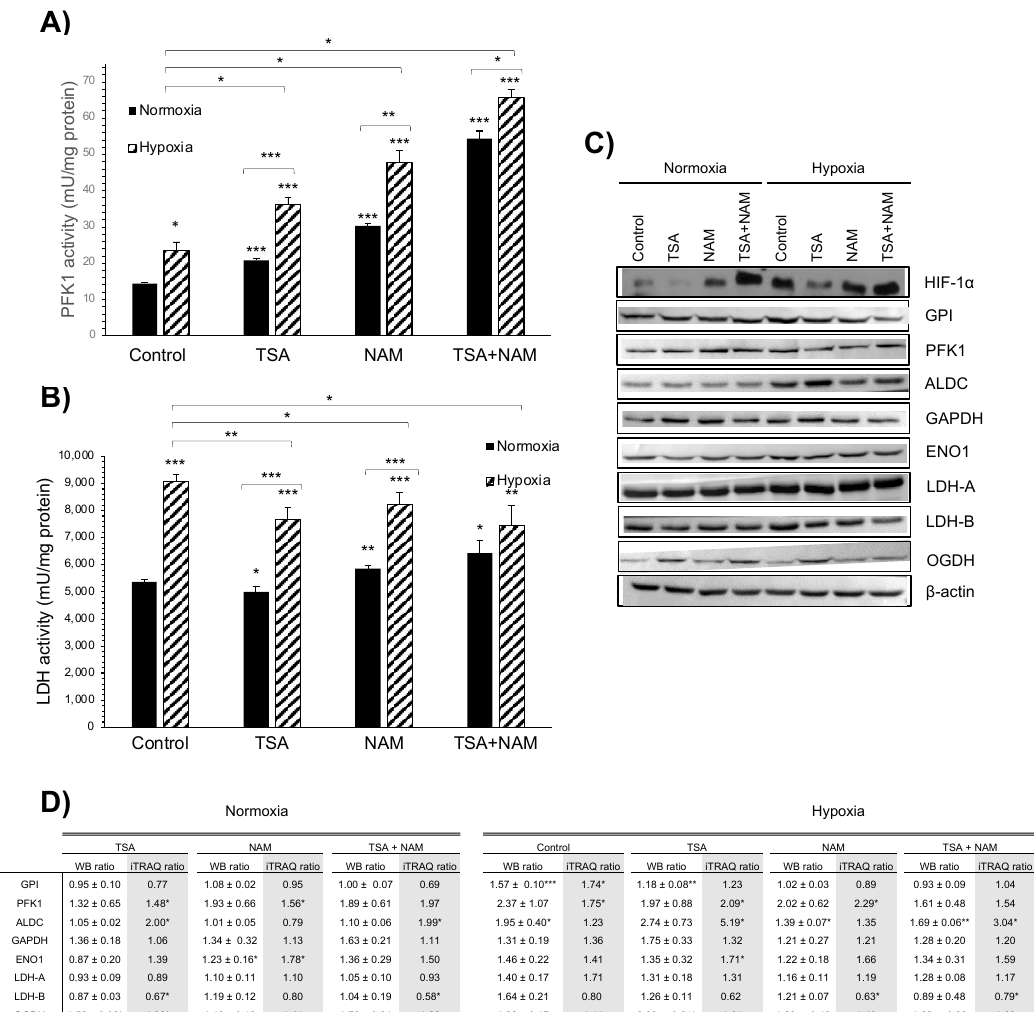
Figure 4. Effect of KDAC inhibition on enzyme activities in A549 cells under normoxia and hypoxia. ( A , B ) The ATP- dependent 6-phosphofructokinase (PFK1) ( A ) and lactate dehydrogenase (LDH) ( B ) enzymatic activities were measured after 24 h of incubation, and activities were normalized to intracellular protein content in each condition. A549 cells were treated with 1 μ M of TSA, 20 mM of NAM, and both 1 μ M TSA and 20 mM NAM for 24 h of incubation under normoxia and hypoxia. Cells incubated in medium without KDACIs served as control. Bars represent the means ± standard error of the mean of three independent experiments. The asterisks above bars indicate statistically significant differences compared to normoxic control cells. The asterisks above curly brackets indicate statistically significant differences between hypoxic and normoxic treatments and between hypoxic treatments and hypoxic control cells. Statistical significance was assessed by a two-tailed Student’s t -test. *, p ≤ 0.05; **, p ≤ 0.01; ***, p ≤ 0.001. ( C ) Western blot images of HIF-1 α and selected metabolic enzymes identified by iTRAQ. A549 cells were treated with 1 μ M of TSA, 20 mM of NAM and both 1 μ M TSA and 20 mM NAM for 24 h of incubation under normoxia and hypoxia. Cells incubated in medium without KDACIs served as control. Immunoblotting of hypoxia-inducible factor-1 α (HIF-1 α ), glucose-6-phosphate isomerase (GPI), phosphofruc- tokinase-1 (PFK1), fructose-bisphosphate aldolase C (ALDC), glyceraldehyde-3-phosphate dehydrogenase (GAPDH), al- pha-enolase (ENO1), lactate dehydrogenase A (LDH-A), lactate dehydrogenase B (LDH-B) and 2-oxoglutarate dehydro- genase (OGDH). β -actin was used as the loading control. ( D ) Densitometry analysis of selected metabolic enzymes shown in C. The ratios of the Western blot bands (WB ratios) of KDACI-treated cells to control cells under normoxia after nor- malization to β -actin. Densitometric values are presented as mean ± standard deviation. Asterisks indicate significant differences compared to untreated normoxic control cells assessed by two-tailed Student’s t -test in WB ratios and R soft- ware package Isobar (iTRAQ ratios) * p ≤ 0.05; ** p ≤ 0.01; *** p ≤ 0.001.